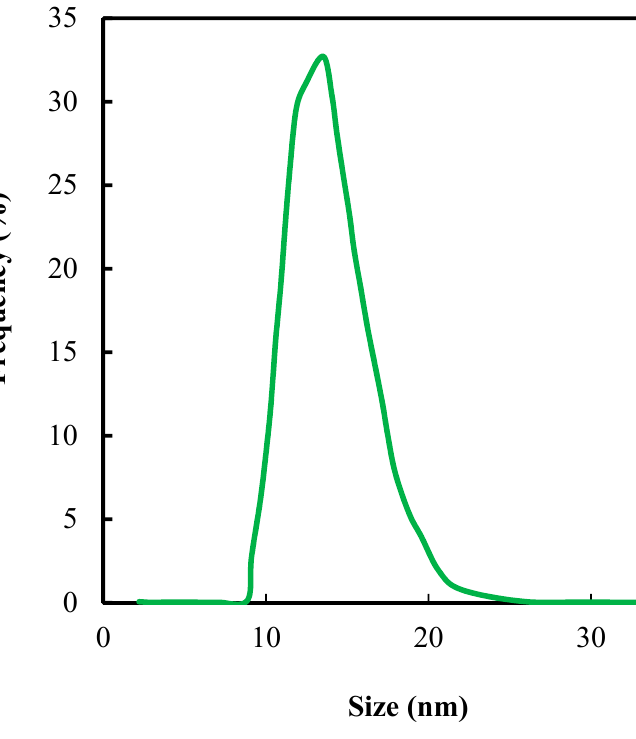
Figure 2. DLS of SNPs.